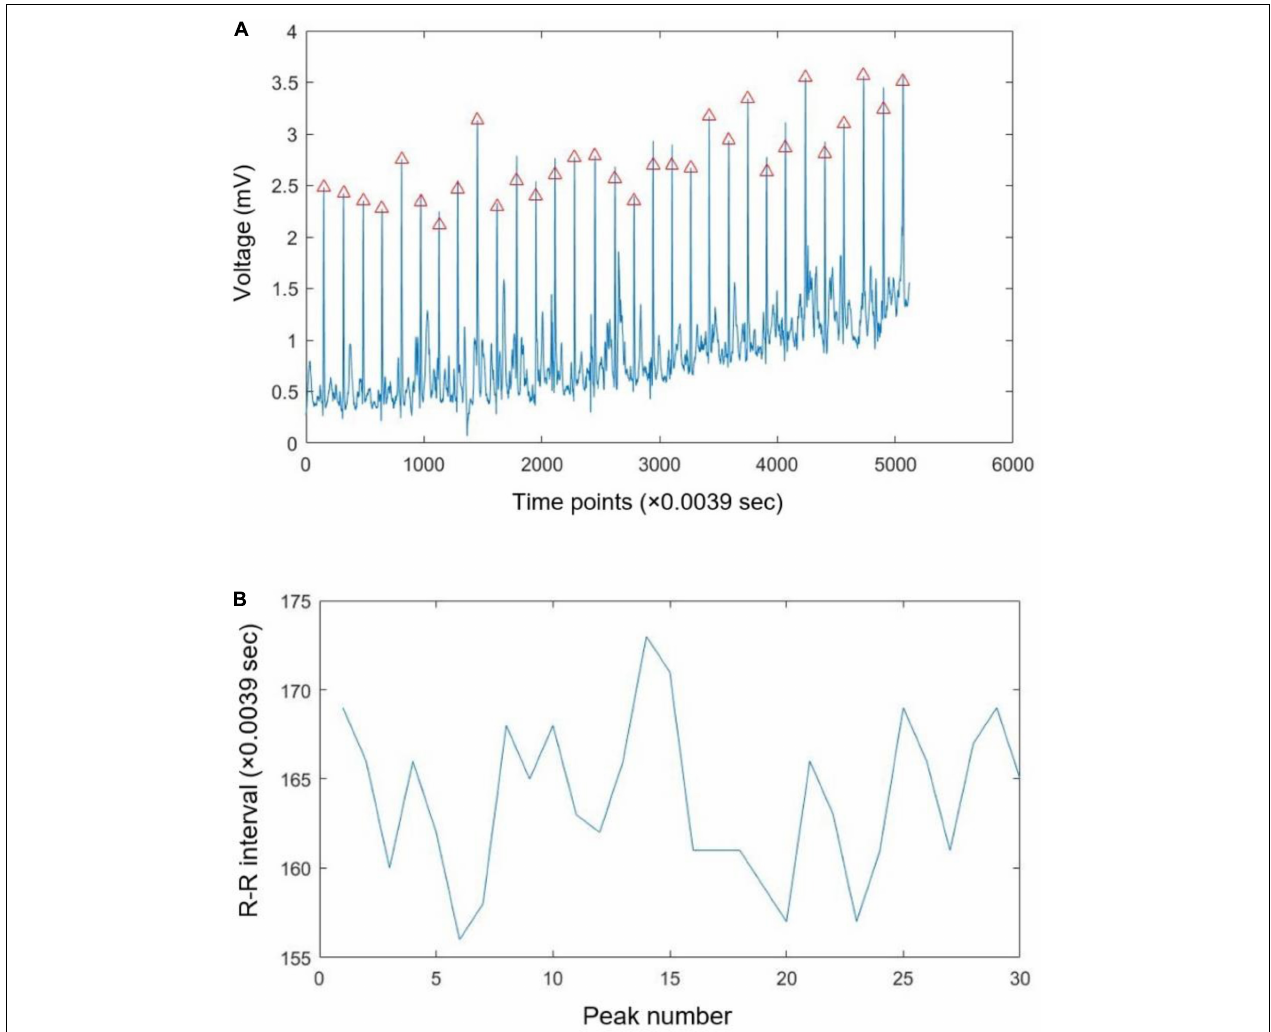
FIGURE 2 | A sample of recorded ECG signal with the specified R peaks (A) and extracted R-R time series (B) .